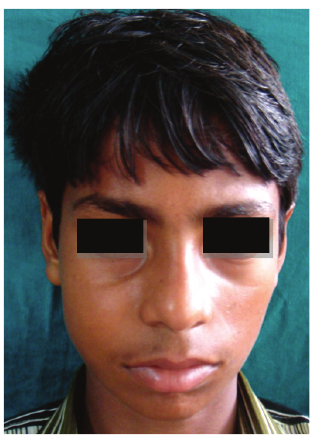
Figure 1: Swelling over the right cheek region. Figure 2: Intraoral photograph at first visit.